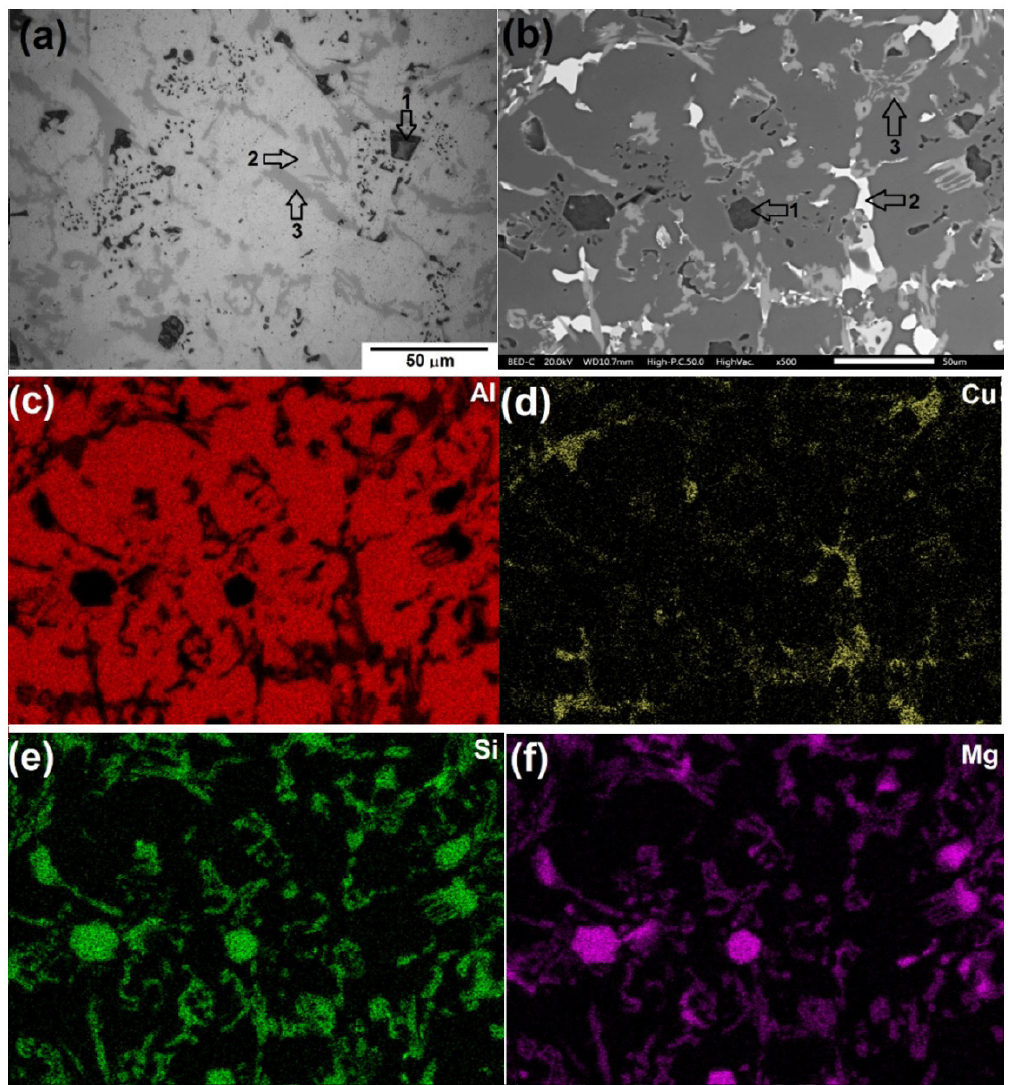
Figure 4. OM (a) and BE-SEM (b) micrographs of the experimental alloys with Cu content of 7%, and EDX-mappings corresponding to Al (c), Cu (d), Si (e) and Mg (f). Arrows indicate second phases: (1) Mg